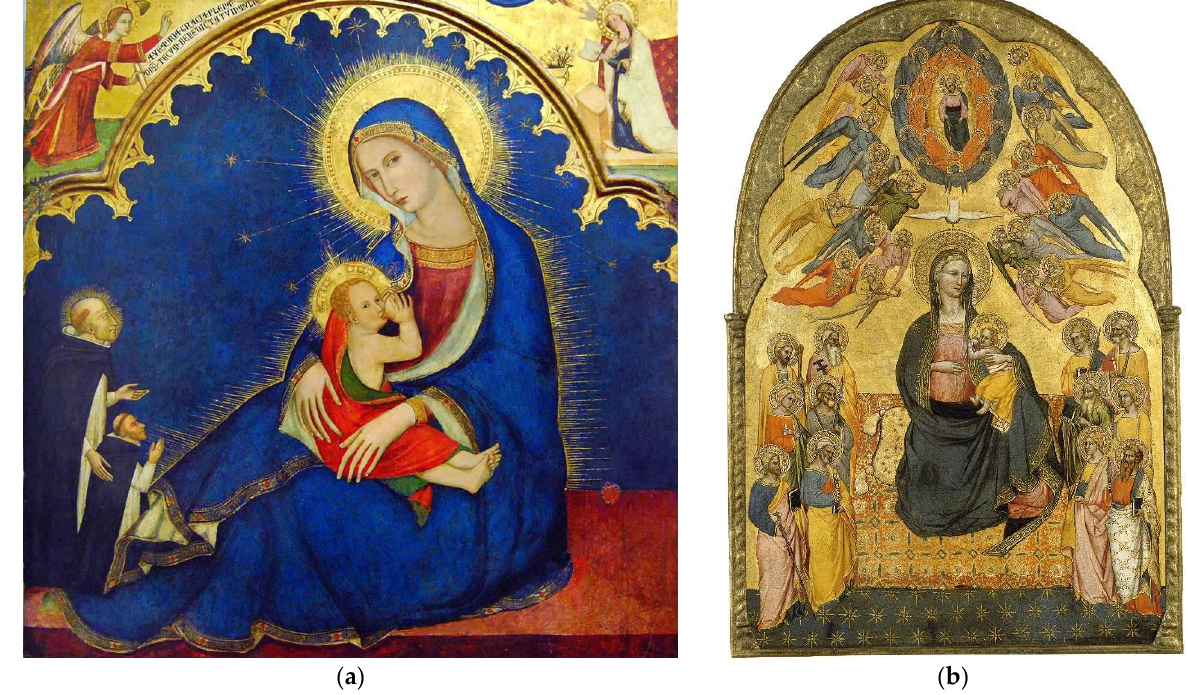
Figure 5. ( a ) Madonna of Humility with saint Dominic and a donor, Maestro delle Tempere francescane, 1350–1355, Naples, Museo di Capodimonte; ( b ) Madonna of Humility with the Eternal Father, the Holy Spirit and the Twelve Apostles, Francesco di Cenni, 1375–1380, Thyssen-Bornemisza collection, Barcelona, Museu Nacional d’Art de Catalunya, 212805-000.